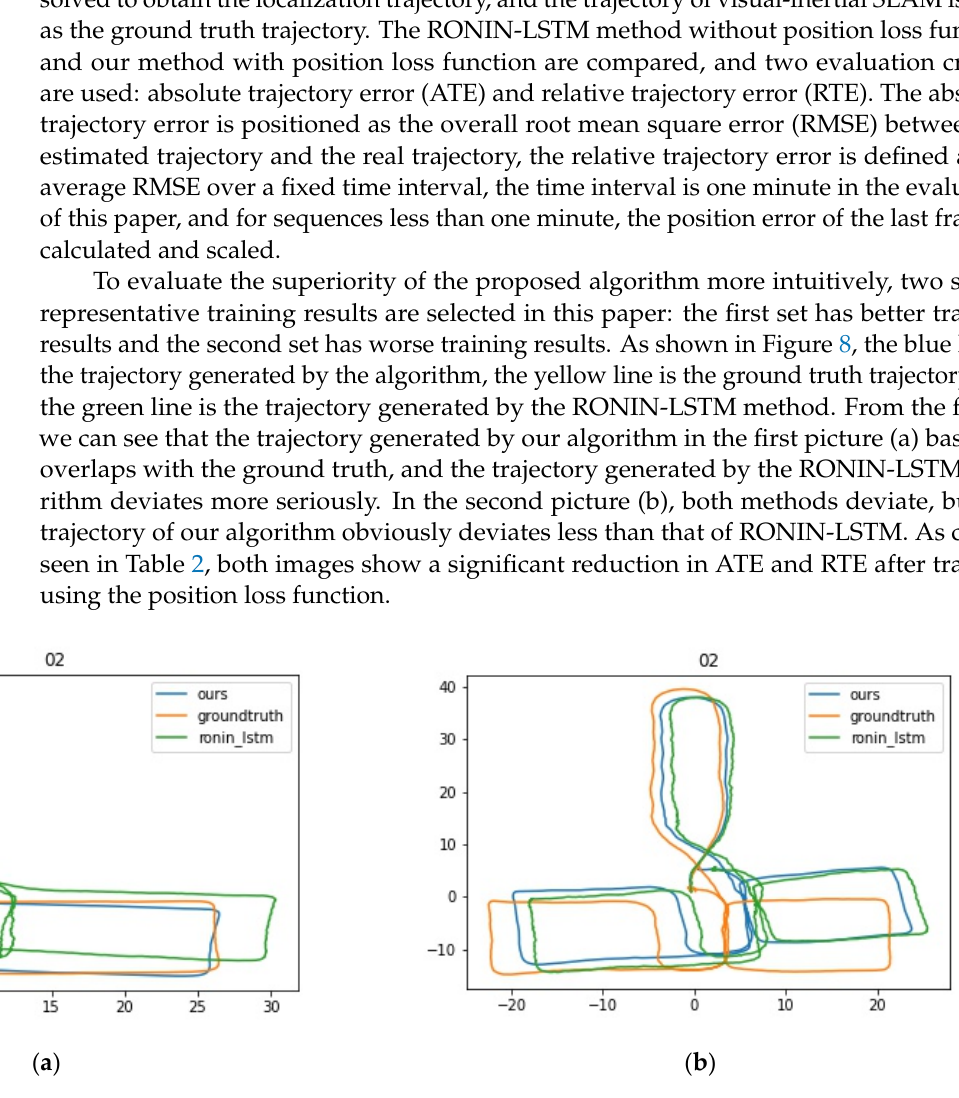
Figure 8. Trajectories of the two methods on the dataset. Table 2. ATE and RTE for both methods.